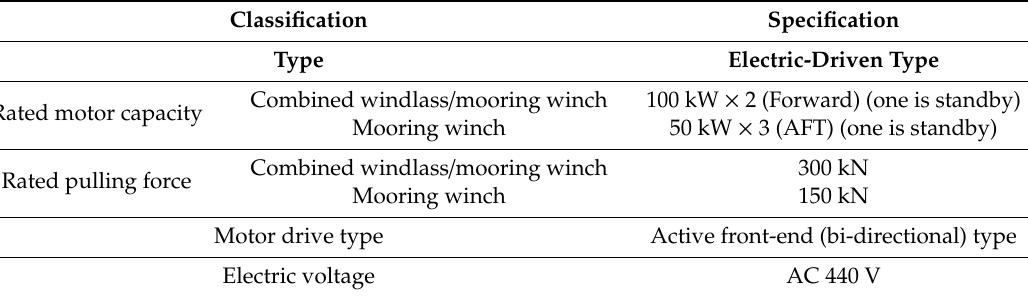
Table 3. Specifications of windlass / mooring